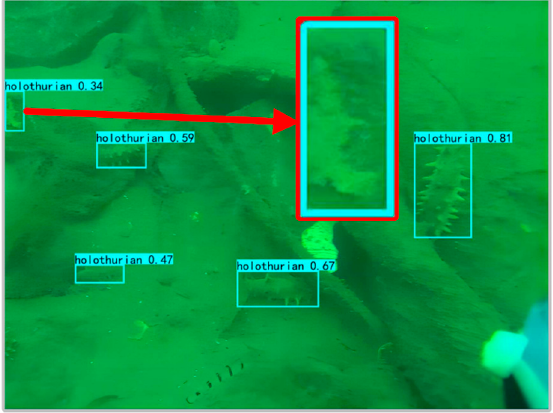
Figure 9. Waterweed falsely tested as holothurian.